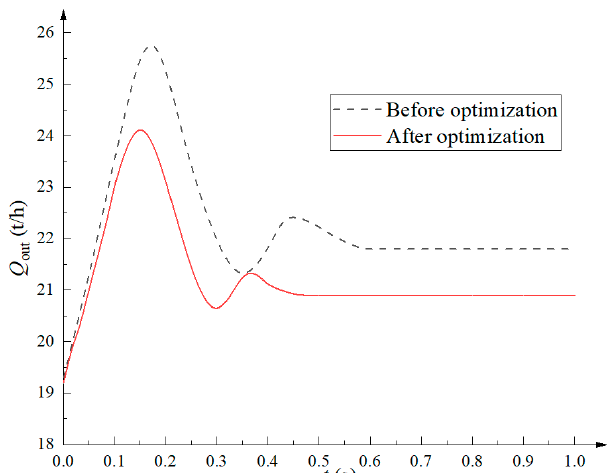
Figure 23. Comparison of dynamic characteristic curves before and after optimization.